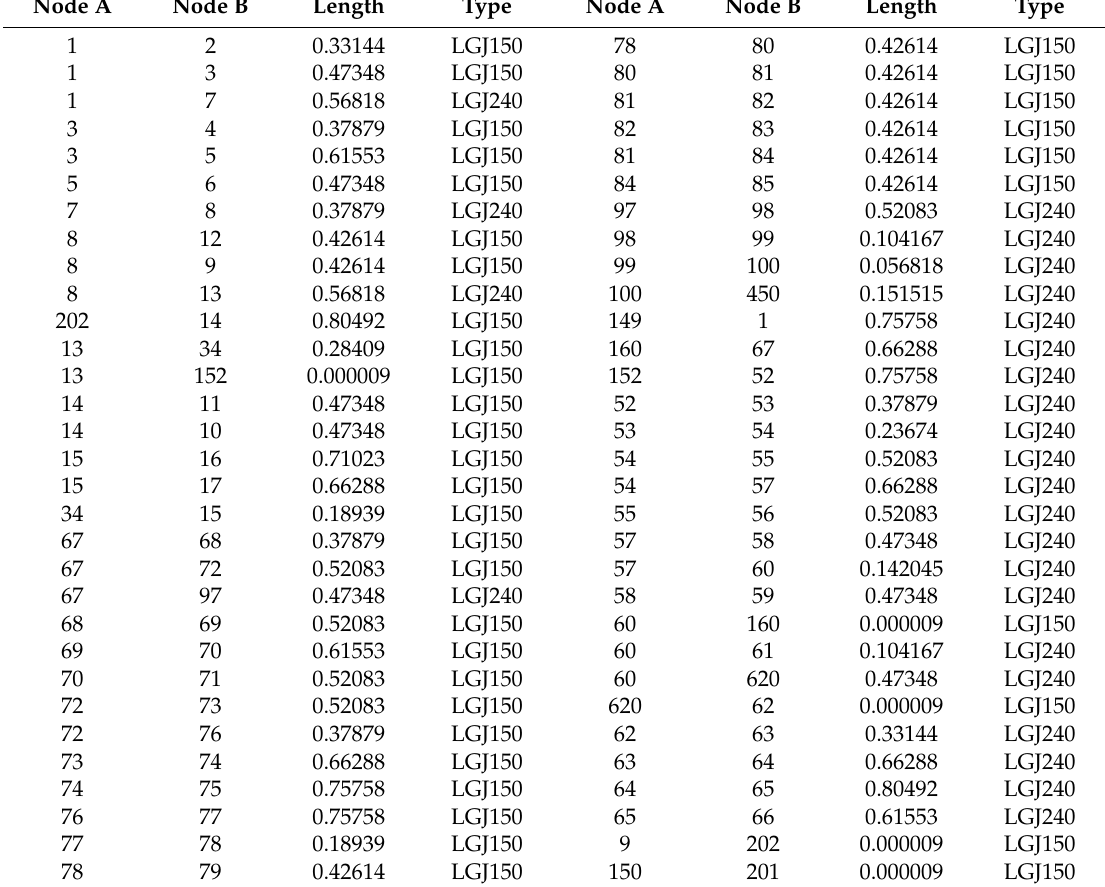
Table A1. Line segment data from the case